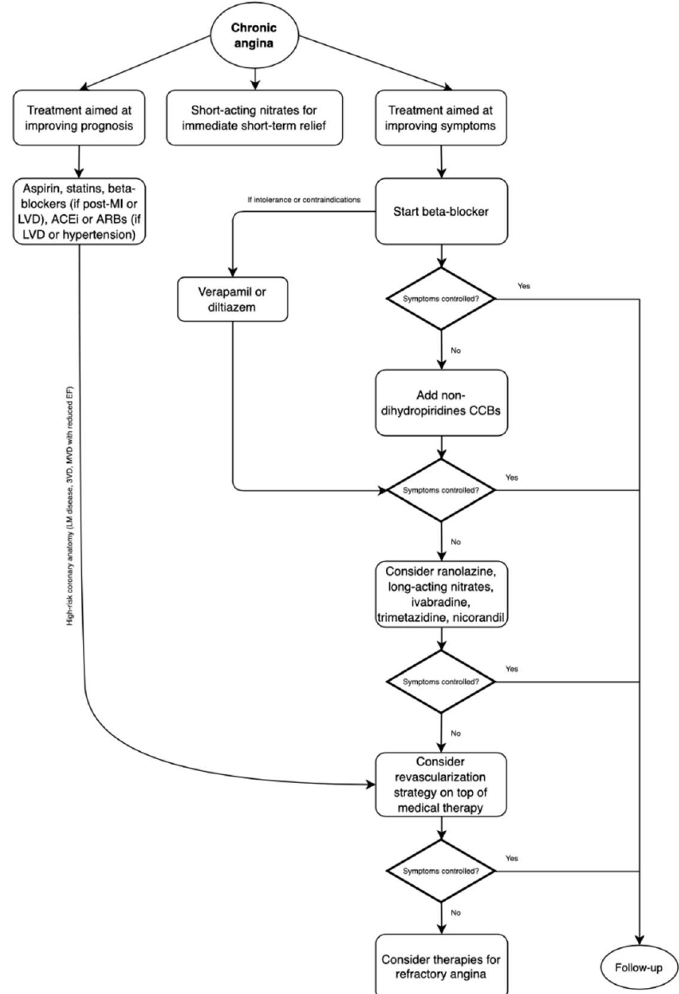
Figure 1. Management of chronic angina due to obstructive coronary artery disease. MI: myocardial infarction, LVD: left ventricular dysfunction, ACEi: angiotensin-converting enzyme inhibitors, ARBs: angiotensin-receptor blockers, CCBs: calcium channel blockers.